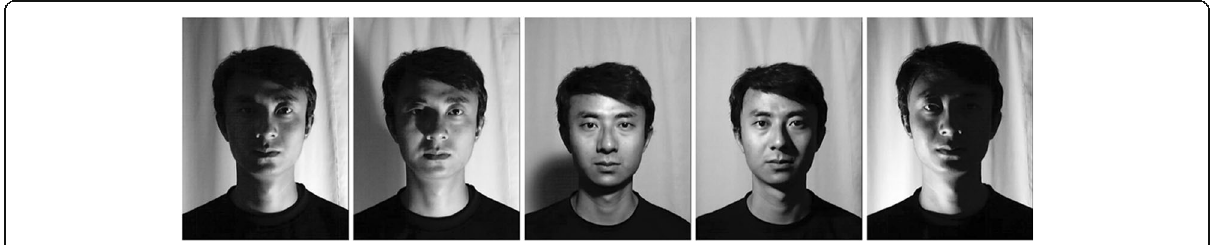
Fig. 3 Face images of samples in different